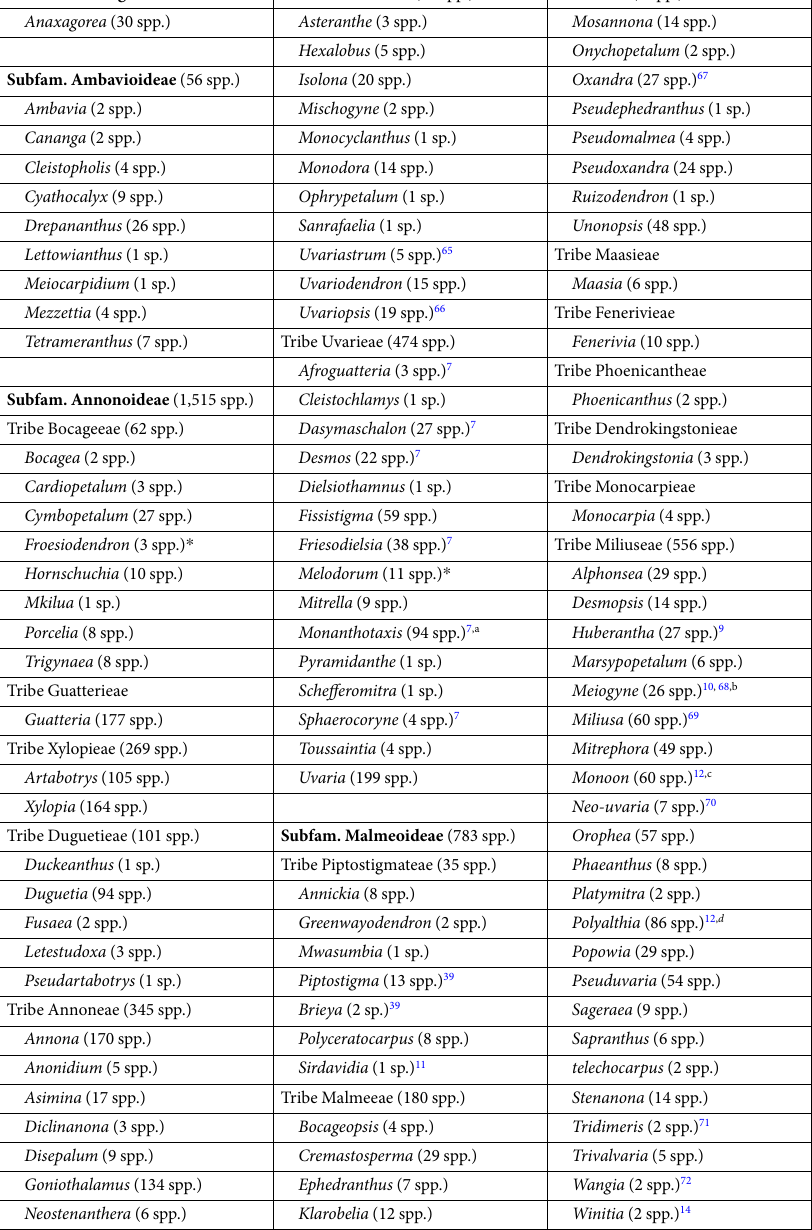
Table 1. List of currently recognised genera of Annonaceae. Unless indicated otherwise, number of recognised species is based on AnnonBase 64 . Subfamilies and tribes arranged according to the phylogenetic trees (Figs 1, 2); genera listed alphabetically within tribes. * Genera not included in the phylogenetic analyses presented here. a Current delimitation includes Exellia , Gilbertiella and African Friesodielsia 7 . b Current delimitation includes Fitzalania , Oncodostigma and some Polyalthia species from Fiji 10 . c Current delimitation includes Enicosanthum and Woodiellantha 12 . d Current delimitation includes Haplostichanthus 12